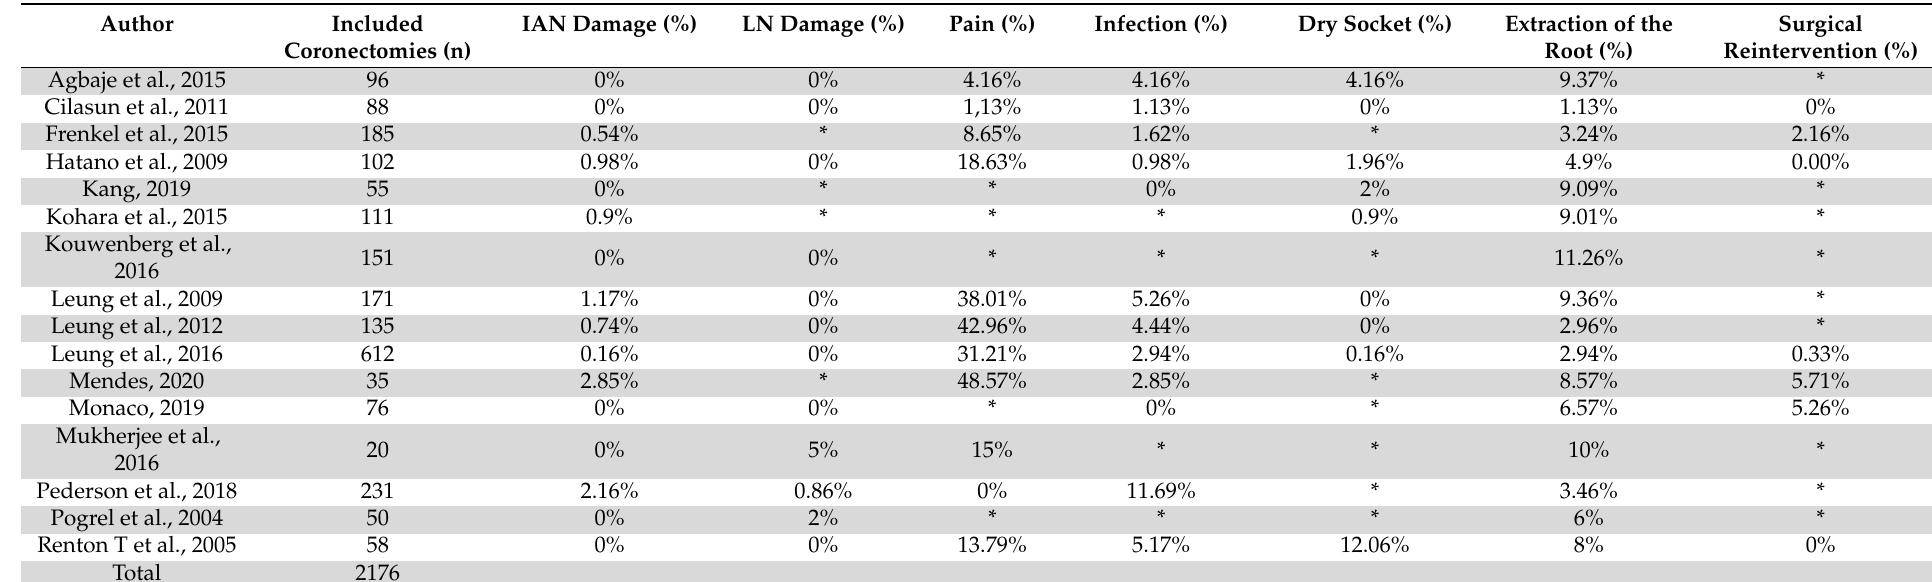
Table 2. Corononectomies evaluation included in each